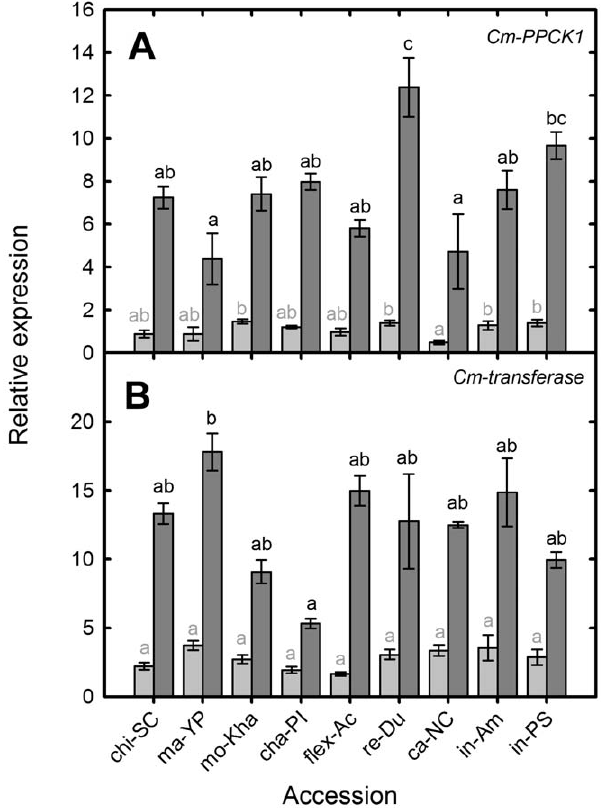
Figure 5. Root transcript abundance for Cm-PPCK , Cm-transfer- ase in nine diverse melon accessions under P replete and P starved conditions. Relative transcript abundance for (a) Cm-PPCK1 [MU52466], (b) Cm-transferase [MU47437] in different melon accessions grown hydroponically with a full nutrient solution (Control, light grey) or nutrient solution containing no phosphate (NoP, dark grey) for 21 d. Transcript abundance was measured using quantitative PCR (Q-PCR) and expressed relative to that of the housekeeping gene ( Cm-Ubiquitin ). Grey bars with the same grey letter are not significant different at P , 0.05 by Newmans Keuls multiple range test. Dark grey bars with the same letter are not significant different at P , 0.05 by Newmans Keuls multiple range test.